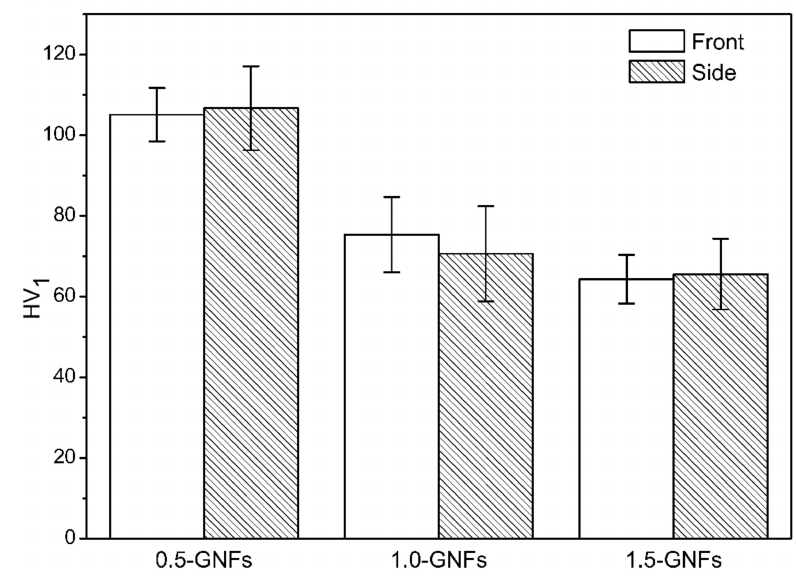
Figure 10. Themicrohardness of the nanocomposites sintered at 1000 ◦ C with different contents of GNFs.